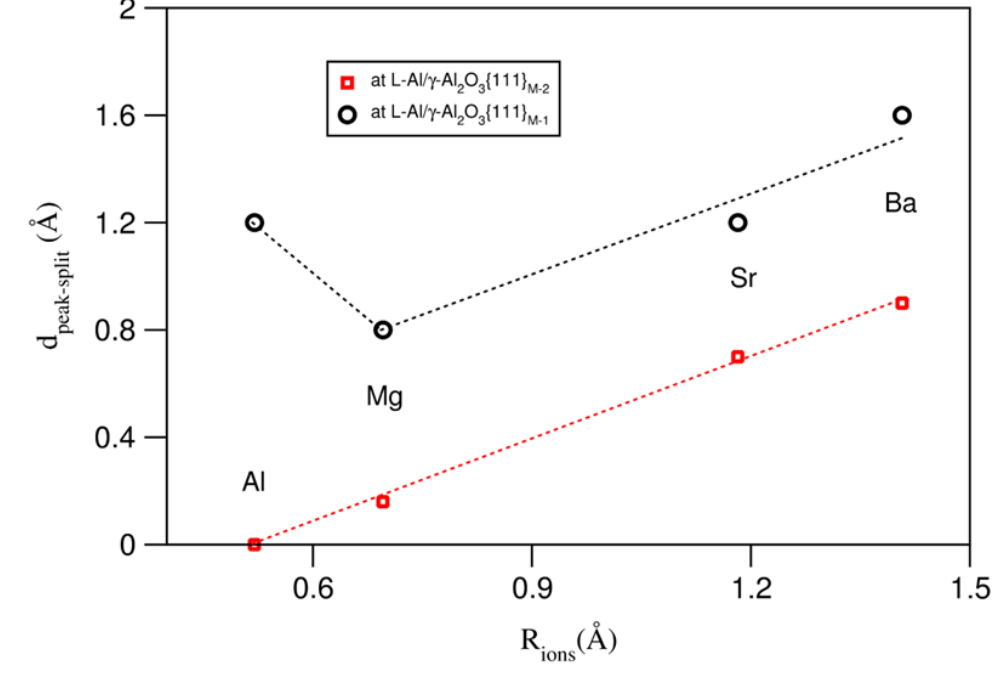
Figure 6. Relationships between distances of the spli tt ing of the termination metal layers at L-Al/ γ - Al 2 O 3 interfaces and the ionic sizes of the AE Al 2 O 3 interfaces and the ionic sizes of the AE atoms.